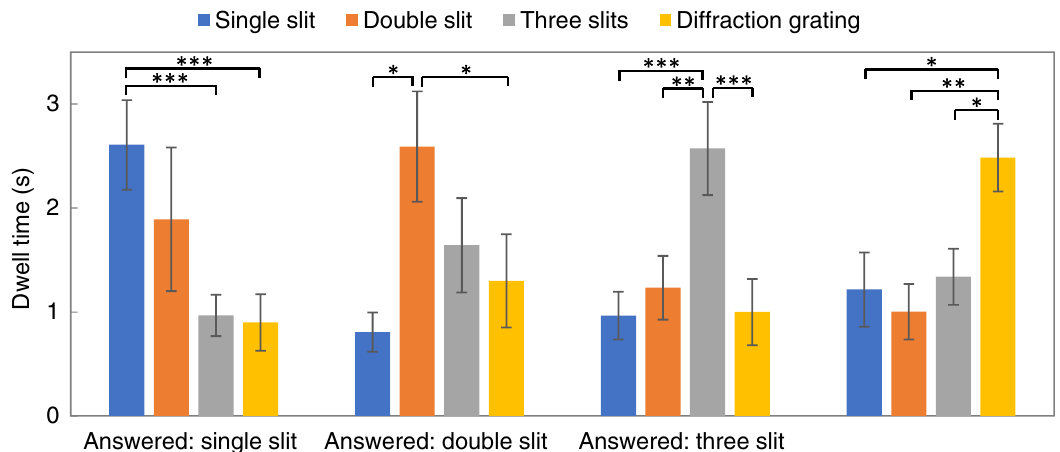
FIG. 8. Dwell times for multiple-choice patterns (single slit, double slit, three slits, and diffraction grating), evaluated separately for students according to their answers to the question to recognize the pattern produced by the interference of red laser light from two coherent sources. One or two asterisks indicate significantly different pairwise comparisons at levels of p < 0 . 05 or p < 0 . 01 , respectively.